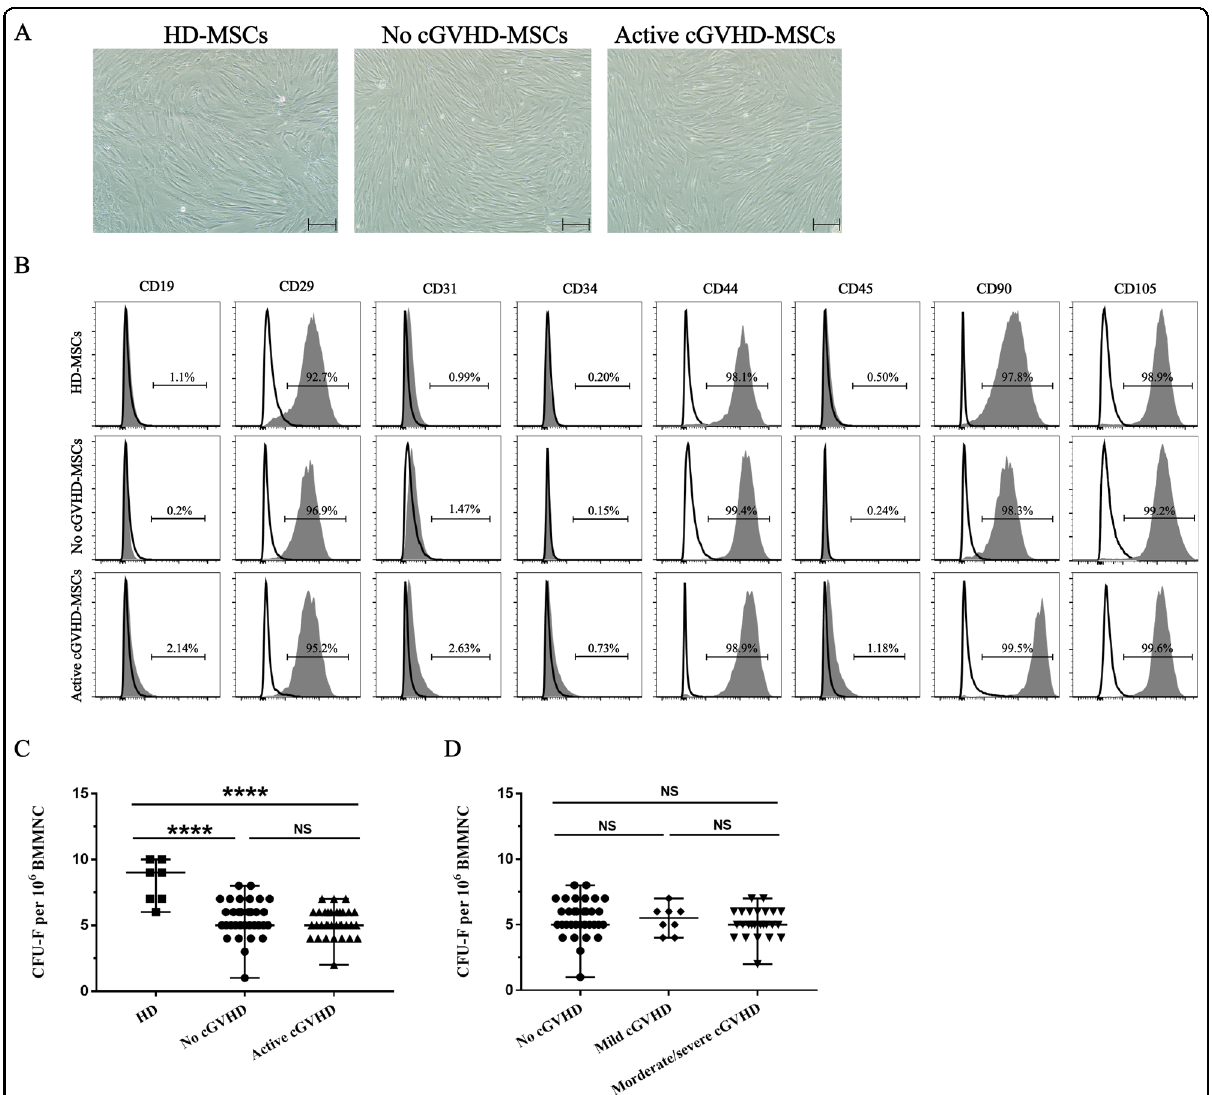
Fig. 1 Similar morphology, immunophenotype, and frequency between MSCs from patients with active cGVHD, patients without cGVHD and heathy donors. A Representative morphology of HD-MSCs, no cGVHD-MSCs, and active cGVHD-MSCs. Scale bar = 200 µm. B Representative fl ow cytometric characterization of cell surface marker expression on MSCs in healthy donors, patients without cGVHD and patients with active cGVHD. Gray- fi lled histograms depict the expression of CD29, CD44, CD90, and CD105 and the absence of CD19, CD31, CD34, and CD45. Isotypic controls are represented by the open histograms. C Frequency of MSCs in healthy donors, patients without cGVHD, and patients with active cGVHD. D Frequency of MSCs in patients with different severities of cGVHD. HD-MSCs ( N = 7), no cGVHD MSCs ( N = 33), mild cGVHD-MSCs ( N = 8) and morerate/severe cGVHD ( N = 25). Black bars in each fi gure represent the median ± range. NS, not signi fi